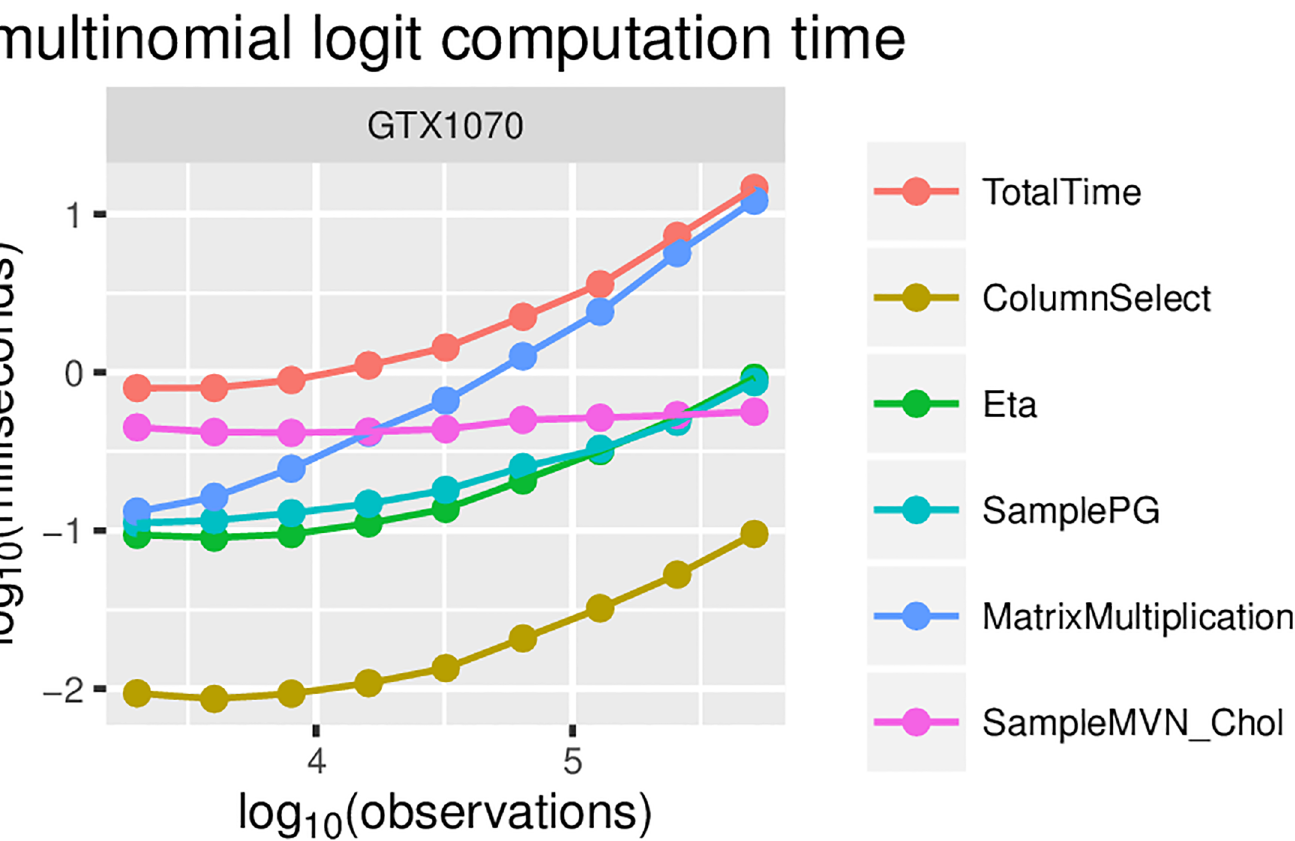
Fig 7. Multinomial logistic regression computation times for GTX1070, broken down by key algorithm components. The results on other GPUs are very similar, and thus, we omit them.